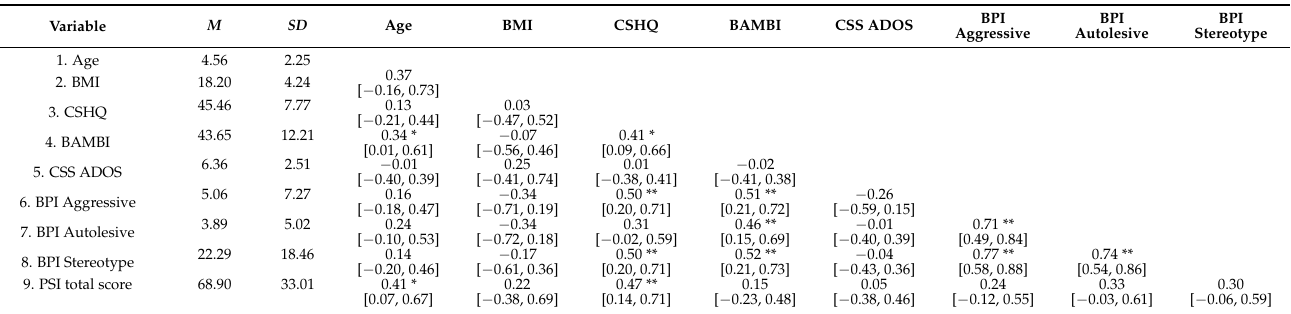
Table 2. Means, standard deviations, and correlations with confidence